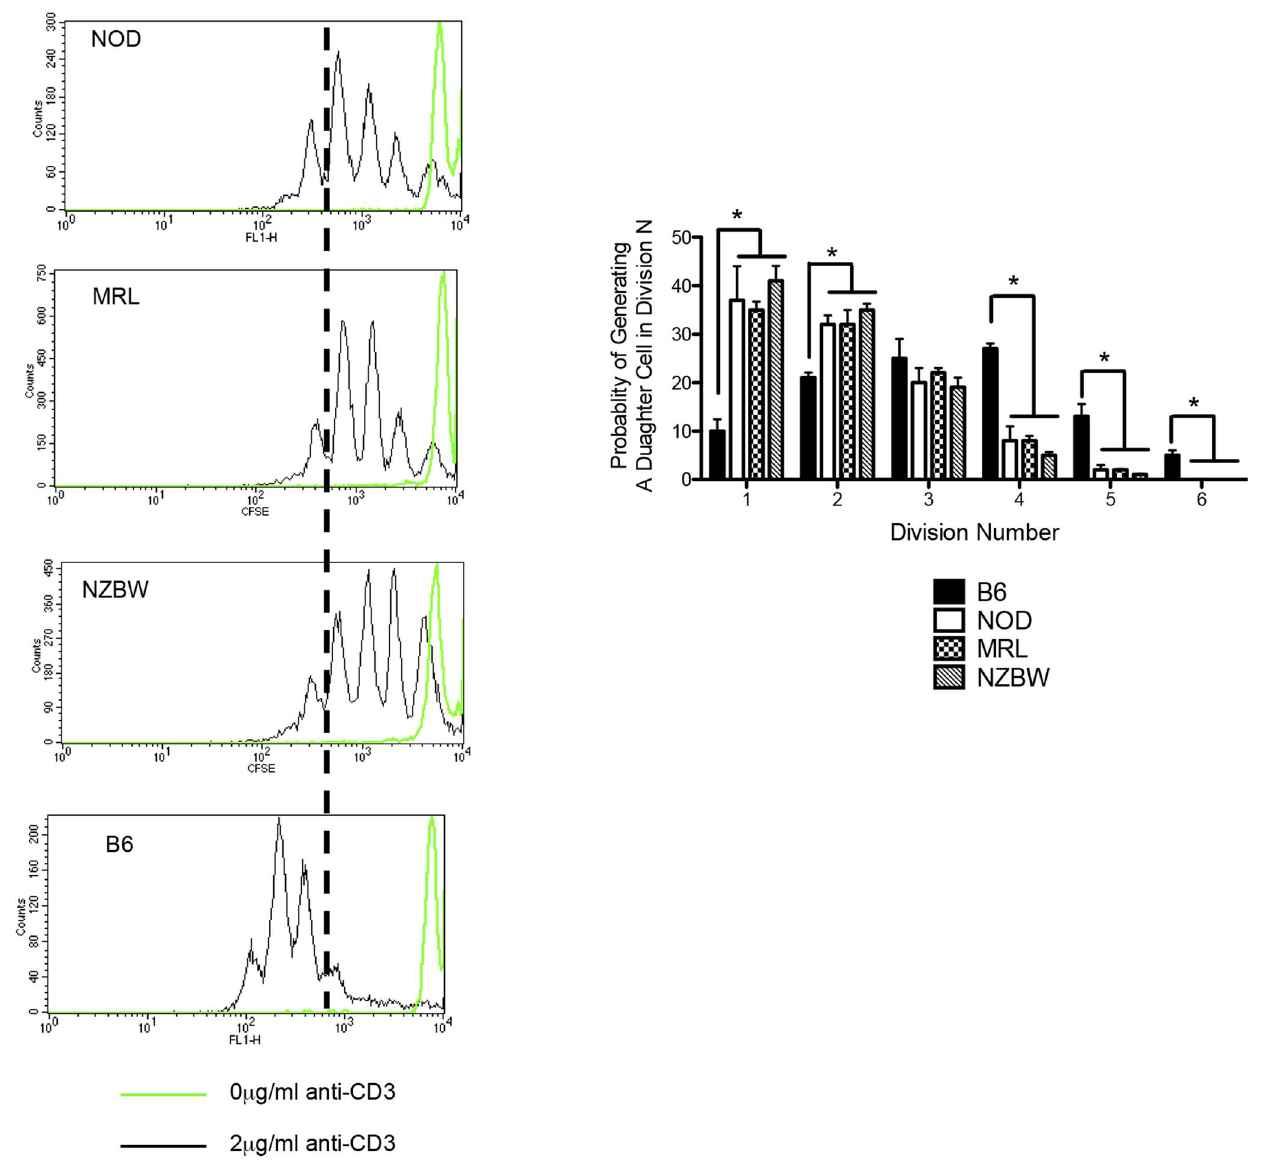
Figure 1. CD4 T cells isolated from autoimmune strains exhibit truncated cell division profiles. A) Splenocytes from NOD, MRL, NZBW, or C57BL/6 female mice at 8–11 weeks of age were labeled homogeneously with CFSE and incubated with 2 m g/ml anti-CD3 and 4 m g/ml anti-CD28 for 65 hours (dotted histogram); unstimulated cells are shown for comparison (solid line). The dotted line demarcates the third division in each graph. B) The probability of reaching any division is identical among autoimmune strains. The probability that a dividing precursor generates a daughter cell in division N was calculated under maximally stimulating conditions (2 m g/ml anti-CD3/28, 65 hours) and represented as a bar graph. An activated CD4 T cell from any autoimmune strain is unlikely to produce a daughter cell in divisions 4–6 (probability , 10%) while there is a significant chance for this event in the normal strain B6 (probability . 40%). The distribution of B6 daughter cells was significantly different from all other strains in each division except division 3 (*p , 0.01, ANOVA followed by post-test, B6 was compared to each other strain, n . 6). All data are representative of at least